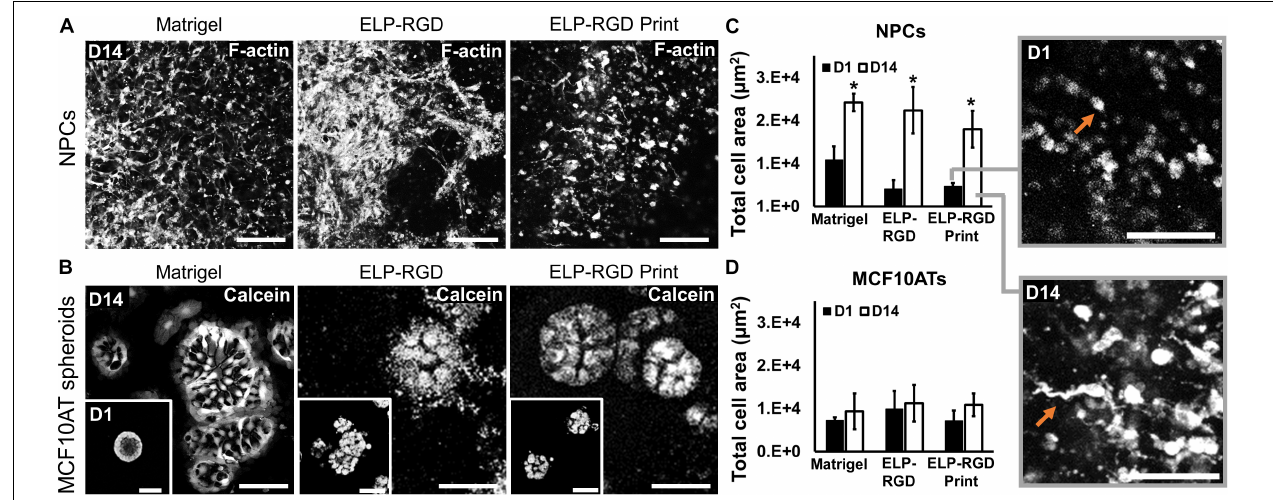
FIGURE 6 | Morphology of dissociated NPCs and MCF10AT spheroids after 14 days of culture within 3D hydrogels. (A) Confocal images of NPCs cultured for 14 days in Matrigel, 3 wt% ELP-RGD without bioprinting, and 3 wt% ELP-RGD after DoD bioprinting. Scale bars represent 100 µ m. (B) Confocal images of MCF10AT spheroids cultured for 14 days in Matrigel, 3 wt% ELP-RGD without bioprinting, and 3 wt% ELP-RGD after DoD bioprinting. Scale bars represent 50 µ m. Insets show MCF10AT spheroids at day 1 of culture in the respective material. Scale bars represent 100 µ m. (C) Total cell area of stained NPCs in confocal images taken at days 1 and 14 of culture. Statistical significance between days 1 and 14 of each material marked as * p < 0.05 ( N = 3, two-tailed t -test, unpaired). Insets are magnified views of NPCs cultured in 3 wt% ELP-RGD after bioprinting, showing round cells at day 1 and spread cells at day 14 (orange arrows). Scale bars represent 100 µ m. (D) Total cell area of stained MCF10AT spheroids in confocal images taken at days 1 and 14 of culture. One-way ANOVA with Tukey’s post hoc test did not show statistical significance between groups.